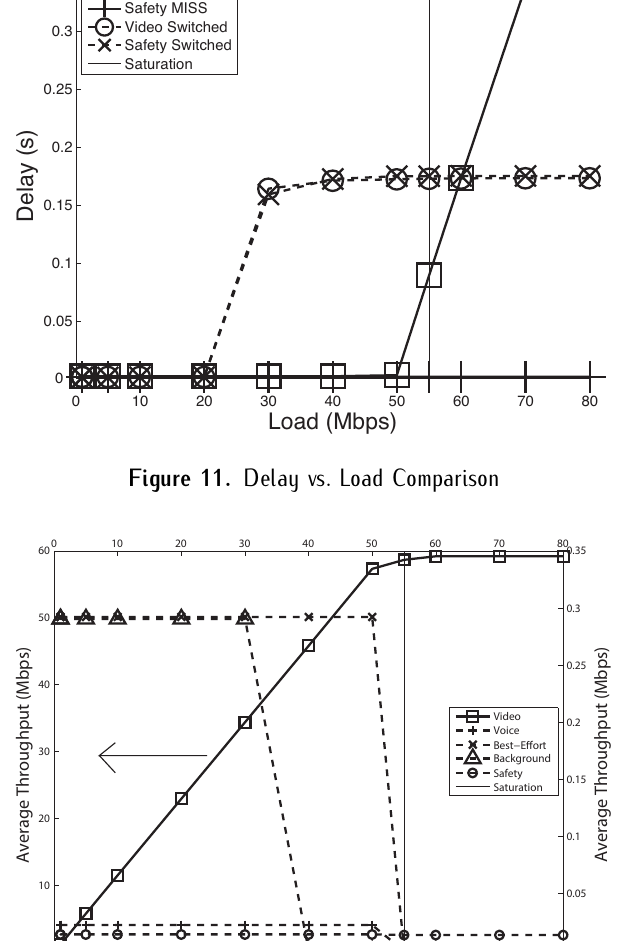
left abscissa corresponds to the video plot, while the right abscissa corresponds to the other tra ffi c services.